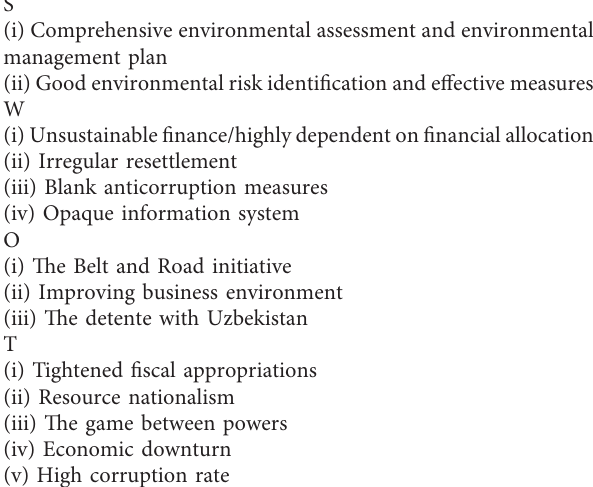
Table 5: SWOTmatrix for sustainable development of Rogun HPP. S (i) Comprehensive environmental assessment and environmental management